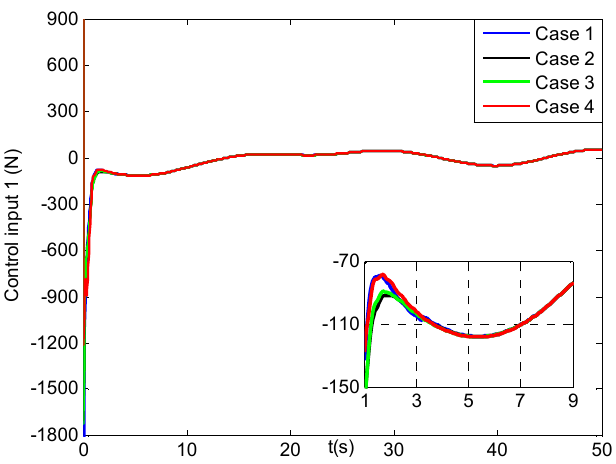
Figure 26. X direction forces for the first control input of the vehicle (four cases).